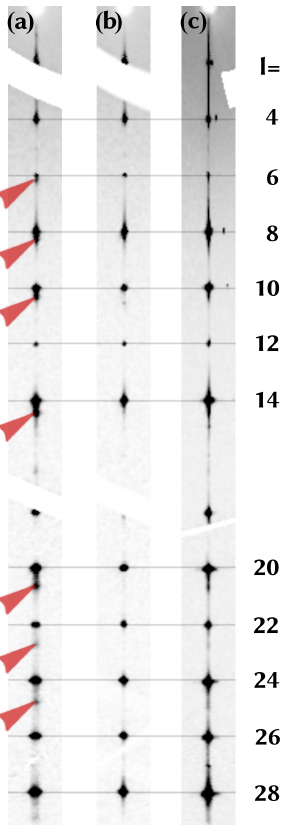
Figure 9. Diffuse scattering of three crystals of kahlenbergite is shown. Stripes (along the 00 l line) of the reciprocal space layer 0 kl are compared. Crystal (a) shows extra reflections (red arrows). which are caused by domains of hibonite, whereas crystal (c) ex- hibits stronger diffuse scattering and only broad maxima at the po- sitions of the hibonite peaks. Data of crystal (b) were used for the structure refinement as the crystal’s diffuse scattering is